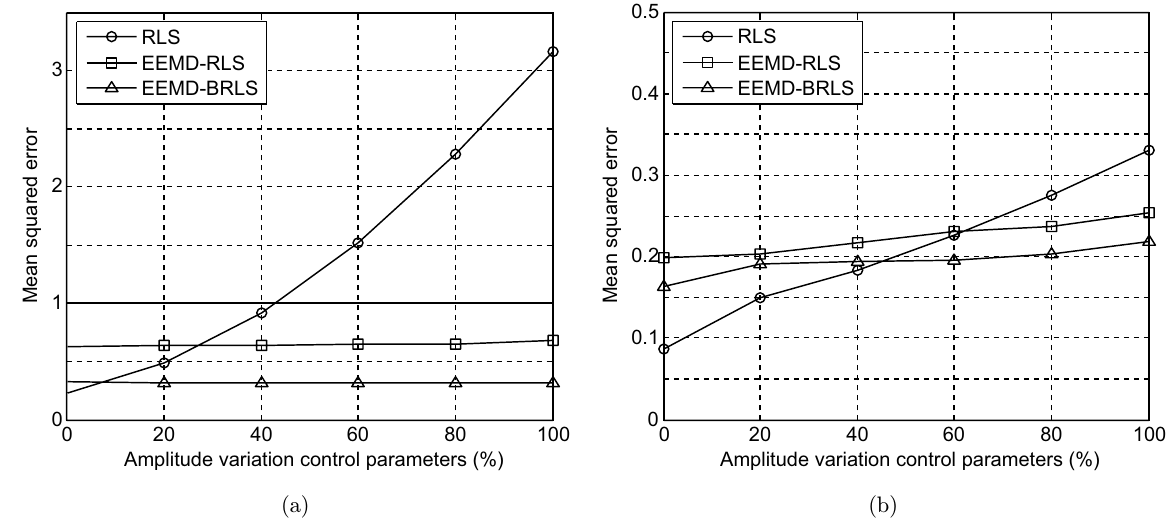
Fig. 6. MSE versus the variation of amplitude control parameters for three di®erent algorithms. (a) The MSE of concentration changes of oxyhemoglobin and (b) the MSE of concentration changes of deoxyhemoglobin.